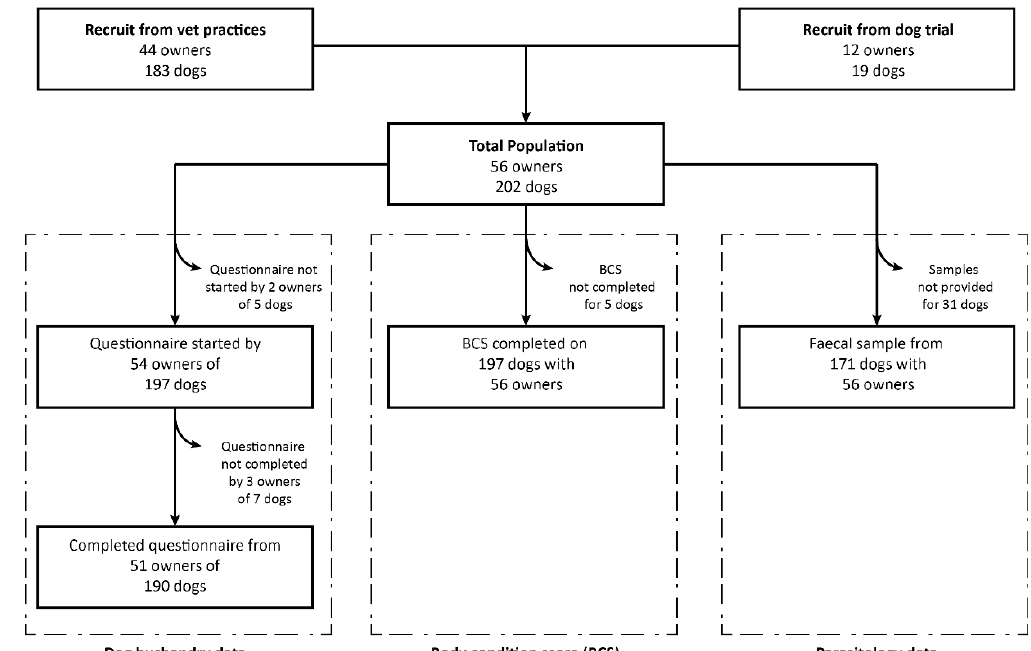
Figure 1. Flowchart describing the recruitment of participants in a cross-sectional survey of working farm dogs in the central North Island of New Zealand.